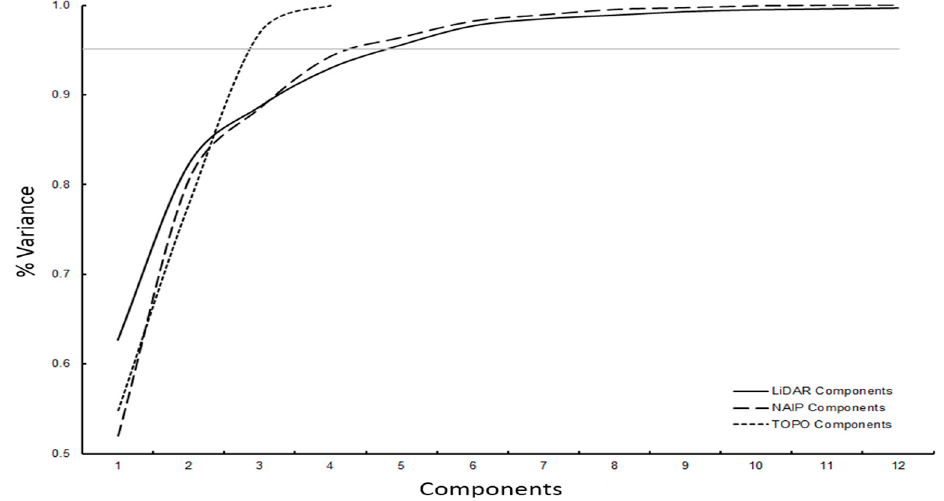
Figure 6. Principal component graph, where LiDAR is solid black, NAIP is dashed, and TOPO is dotted. The solid horizontal line indicates the minimum 95% threshold of the cumulative variation that is explained by the number of principal components.